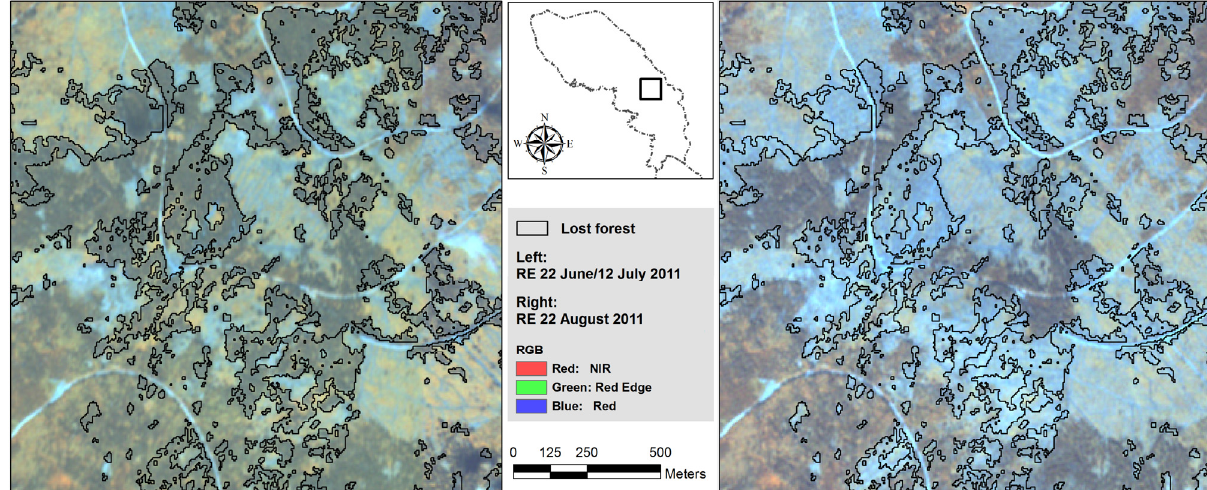
Figure 5. An example showing the forest cover losses during the second period of analysis from 22 June/12 July to 22 August detected using RapidEye